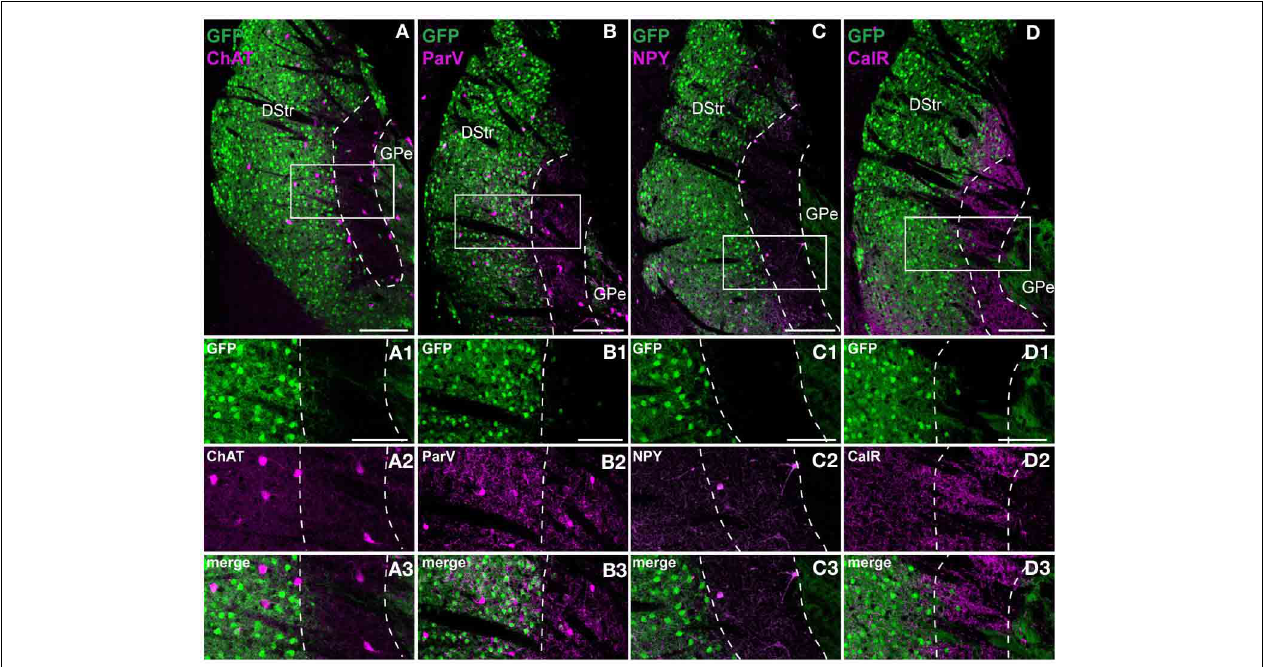
FIGURE 6 | Striatal interneurons distribution in the D2R/A2aR-expressing MSNs-poor zone of the caudal striatum. Striatal sections at the caudal level from Drd2-EGFP mice ( n = 5 for each staining) labeled with antibodies for choline acetyltransferase (ChAT, A ), parvalbumin (ParV, B ), neuropeptide Y (NPY, C ) and calretinin (CalR, D ). Scale bars,